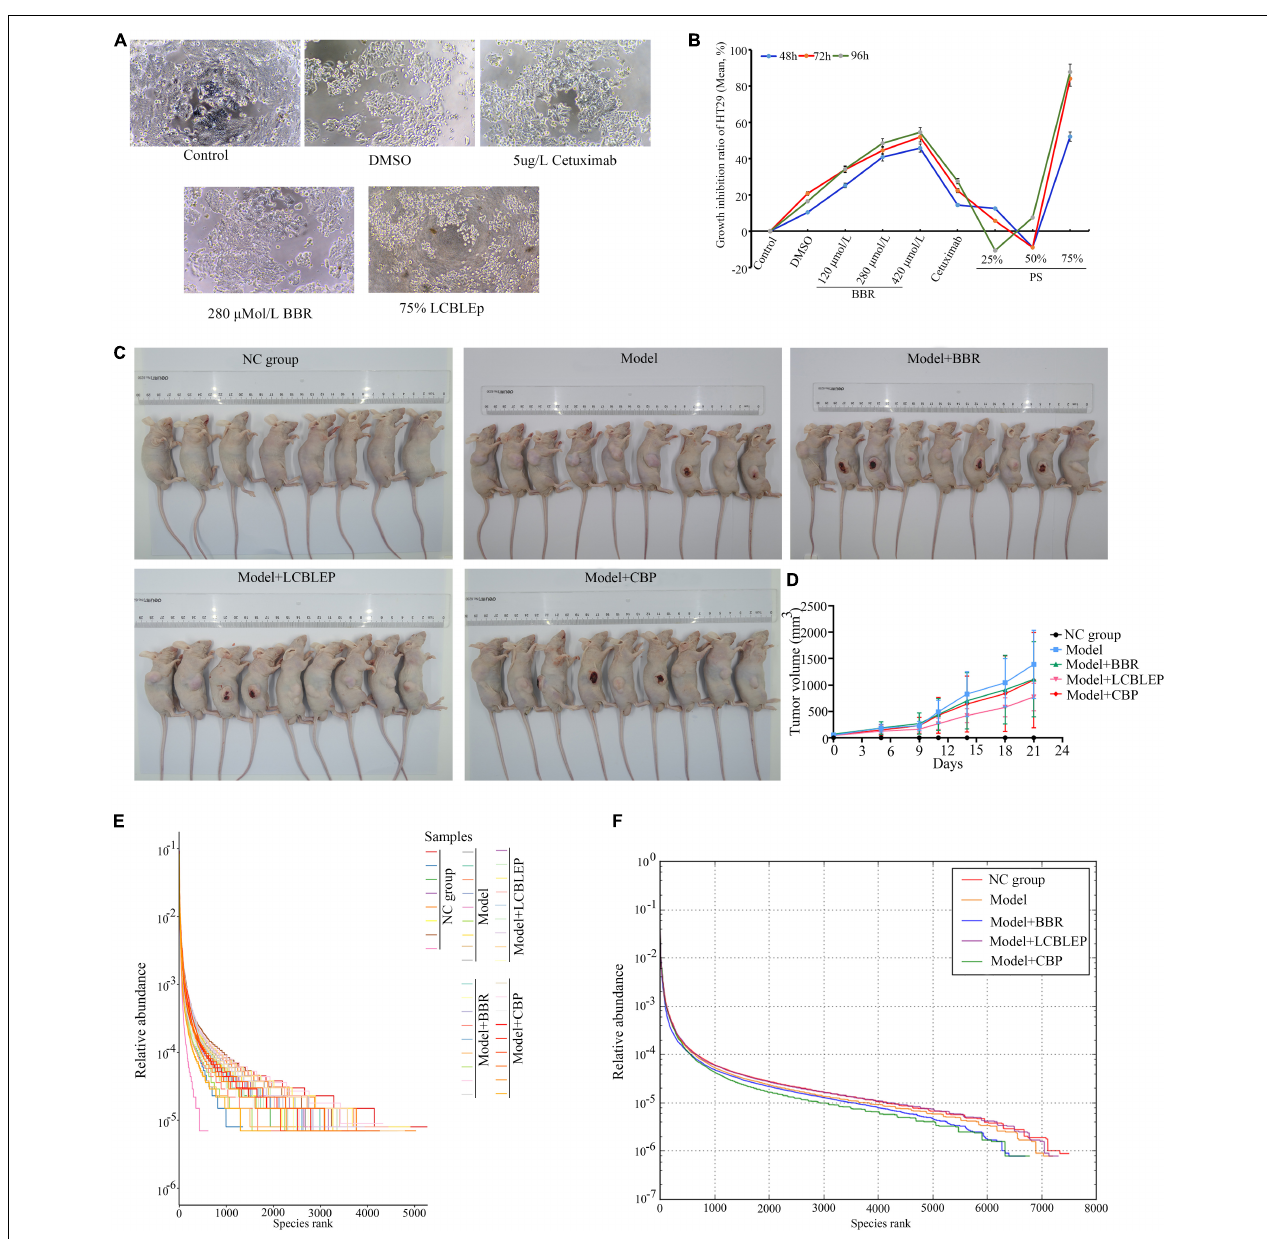
FIGURE 1 | (A) Morphological observation of HT29 cells treated with 75% probiotic supernatant (SB) and berberine (200 × ). (B) Growth inhibition ratio of HT29 cells in different conditions through MTT. BBR, berberine; PS, a probiotic (live combined Bifidobacterium, Lactobacillus, and Enterococcus powder) supernatant (diluted with culture medium). (C) Establishment of xenograft model of colon cancer in nude mice and treatment of berberine and LCBLEP and CBP. (D) Measurement of tumor volume. (E) Rank abundance curve of OTU in all samples presenting richness and evenness of community of species. (F) Rank abundance curve of OTU in each group presenting richness and evenness of community of species. The sequences were clustered into OTUs with 97% similarity by default. OTU analysis was performed using Vsearch v2.4.4. NC group, normal control (8 nude mice); Model, model of colon cancer (9 nude mice); Model + BBR group, model with berberine (BBR) (9 nude mice); Model + LCBLEP group, model with LCBLEP (9 nude mice); Model + CBP group, model with CBP (9 nude mice) (the same